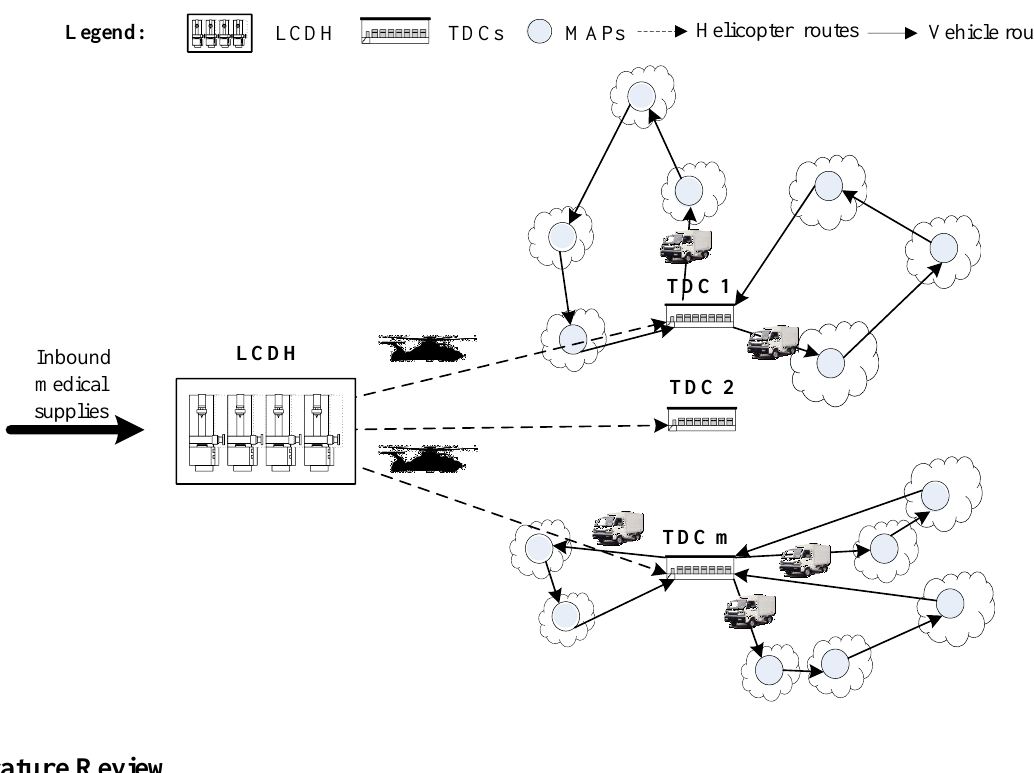
Figure 1. A simplified diagram of the intermodal